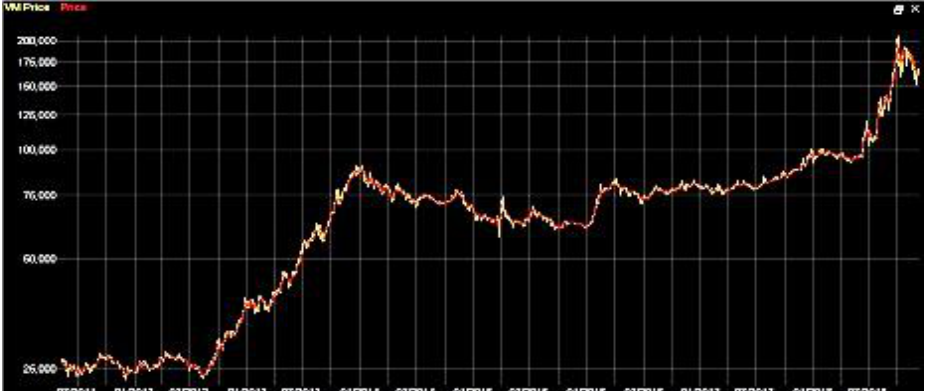
Fig. 2. Time series plot of TEPIX at 95% of the total population; the red curve is the historical “TEPIX” quotes; the yellow curve is the series estimated by ‘Residual